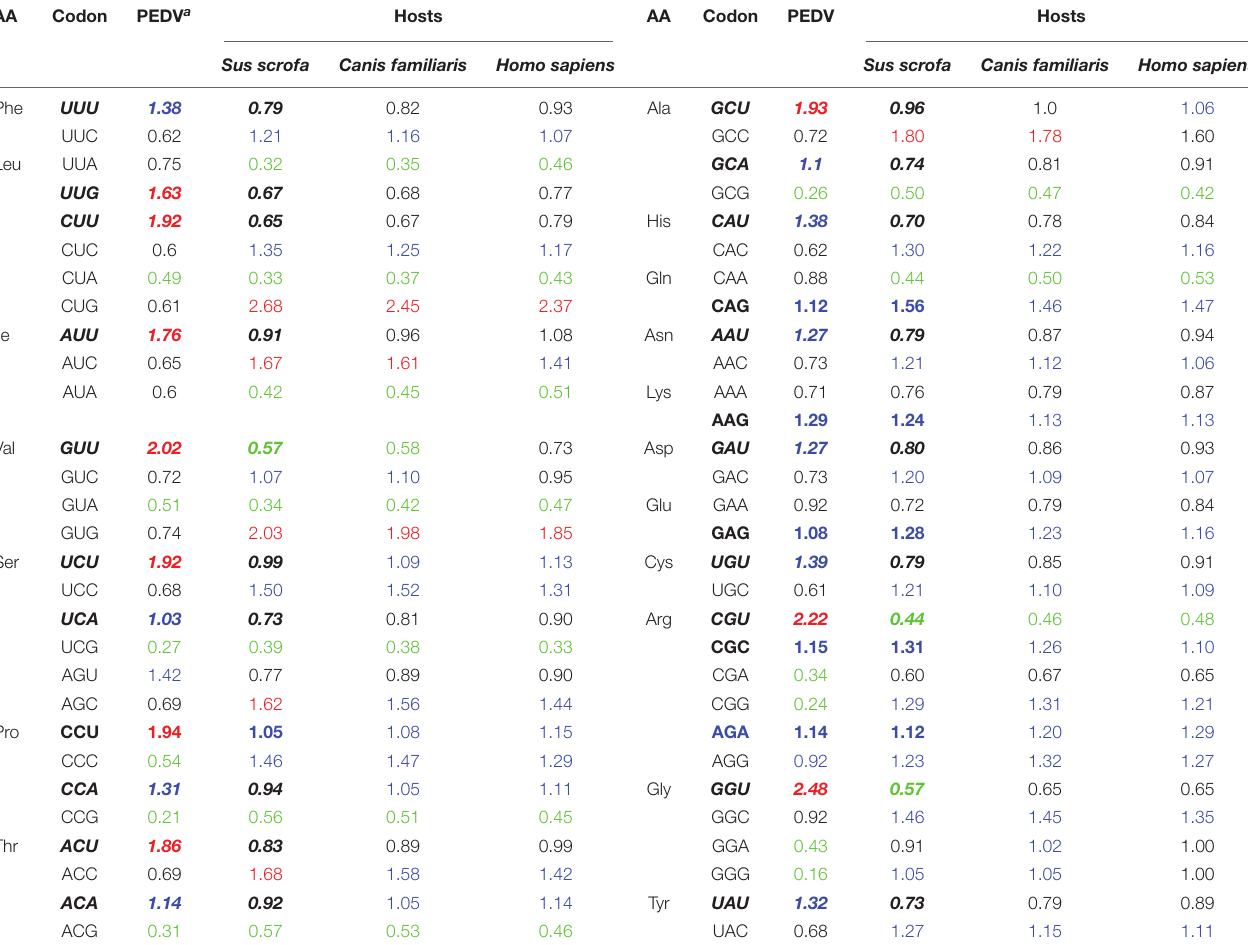
TABLE 1 | The relative synonymous codon usage (RSCU) patterns of PEDV in comparison with the RSCU values of its natural host ( Sus scrofa ) as well as reference animal model hosts including Homo sapiens.